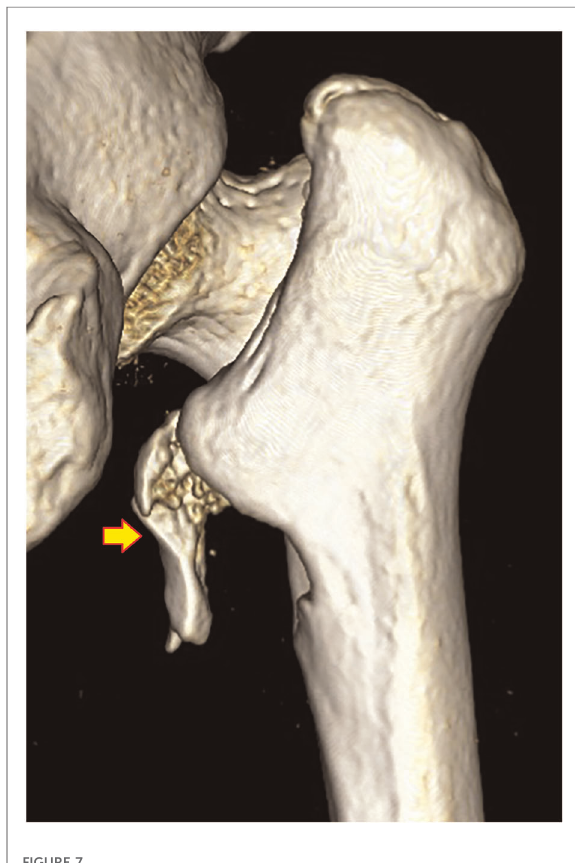
FIGURE 7 Subtype A2.1, with an isolated lesser trochanter fragment. The arrow indicates the displaced lesser trochanter.